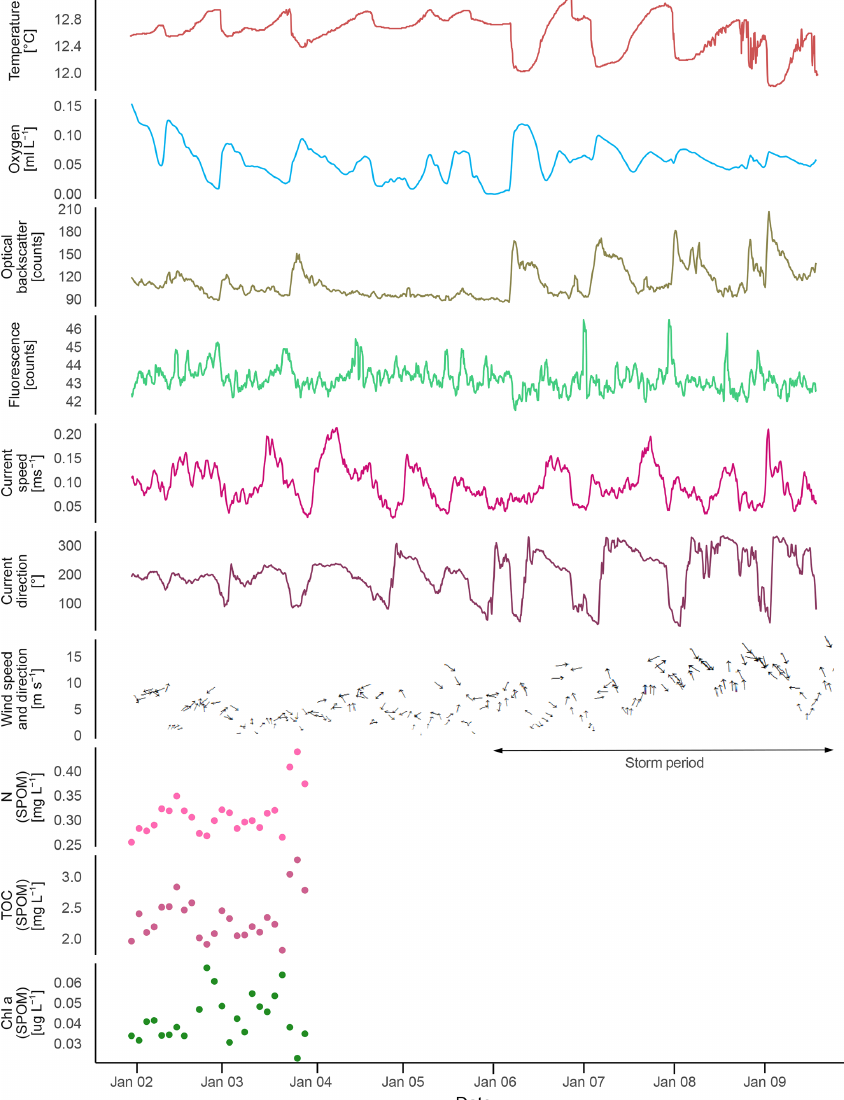
Figure 6. Data recorded by the ALBEX lander (210m) at the Namibian margin in January 2016. Shown are data for temperature ( ◦ C; red), dissolved oxygen concentrations (mLL − 1 ; blue), optical backscatter (turbidity; moss green), fluorescence (counts per second; green), current speed (ms − 1 ; pink), current direction ( ◦ : 0–360 ◦ ; dark red) as well as nitrogen (mgL − 1 ; pink dots), carbon (mgL − 1 ; purple dots), and chlorophyll a concentration (µgL − 1 ; green dots) of SPOM collected during the first 48h by the McLane pump. These data are supple- mented by wind speed and direction (small black arrows) recorded concurrently to the lander deployment by ship bound devices. Note that current directions changed from a generally south-poleward to an equatorward direction when wind speed exceeded 10ms − 1 (stormy period indicated by black